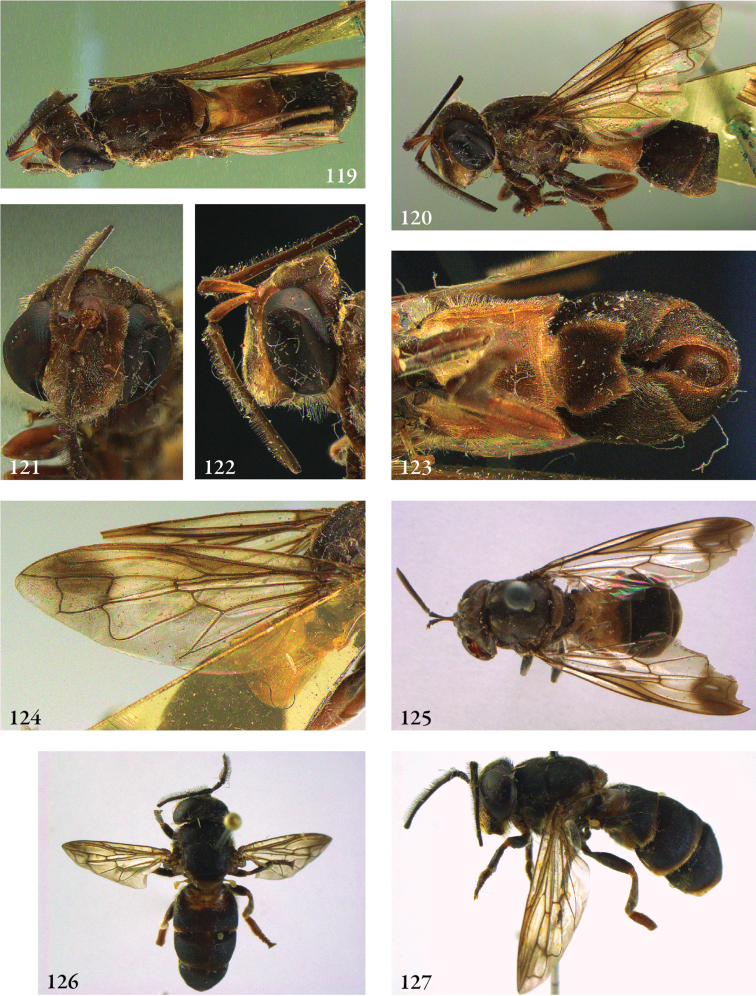
119–124
Kryptopyga pendulosa male (holotype): 119 habitus dorsal 120 habitus lateral 121 head frontal 122 head lateral 123 abdomen ventral 124 wing 125
Kryptopyga pendulosa female (Indonesia, Bangka, coll. RMNH) 126–127
Kryptopyga sulawesiana male (holotype): 126 habitus dorsal 127 habitus lateral.